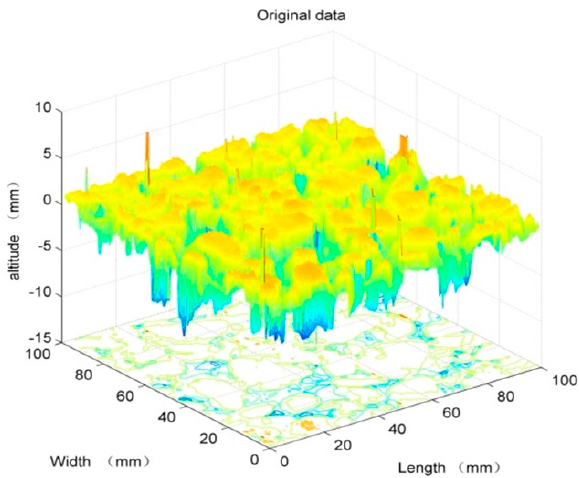
Figure 3. 3D texture reconstruction.